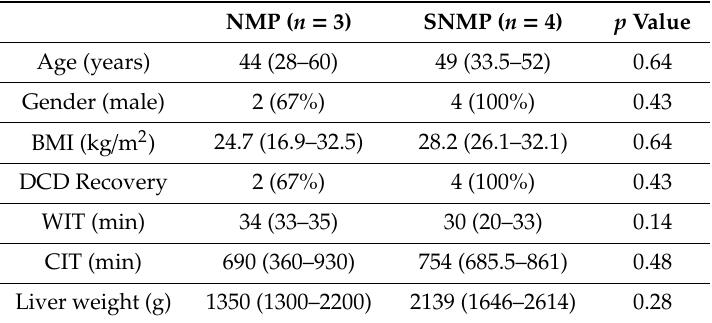
Table 2. Donor demographics of SNMP and NMP non-steatotic livers.